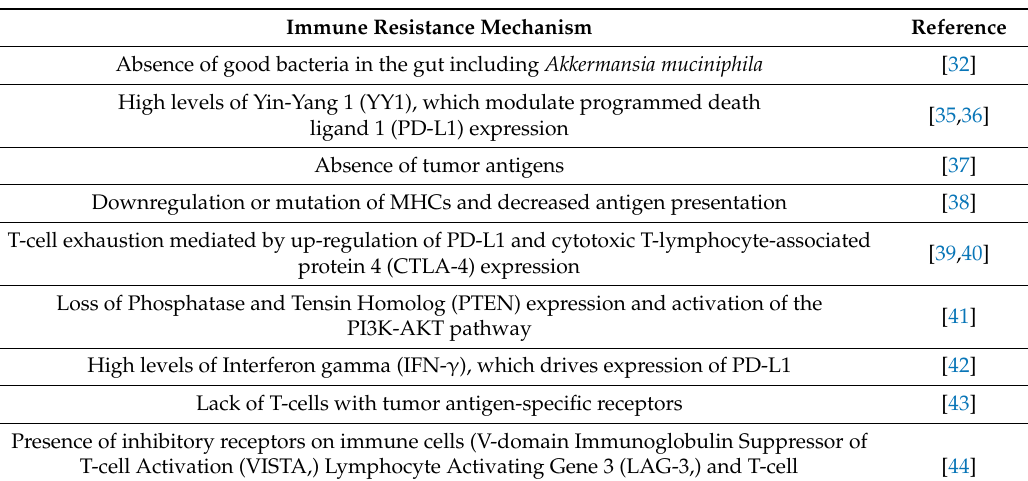
Table 1. Examples of Immune Resistance